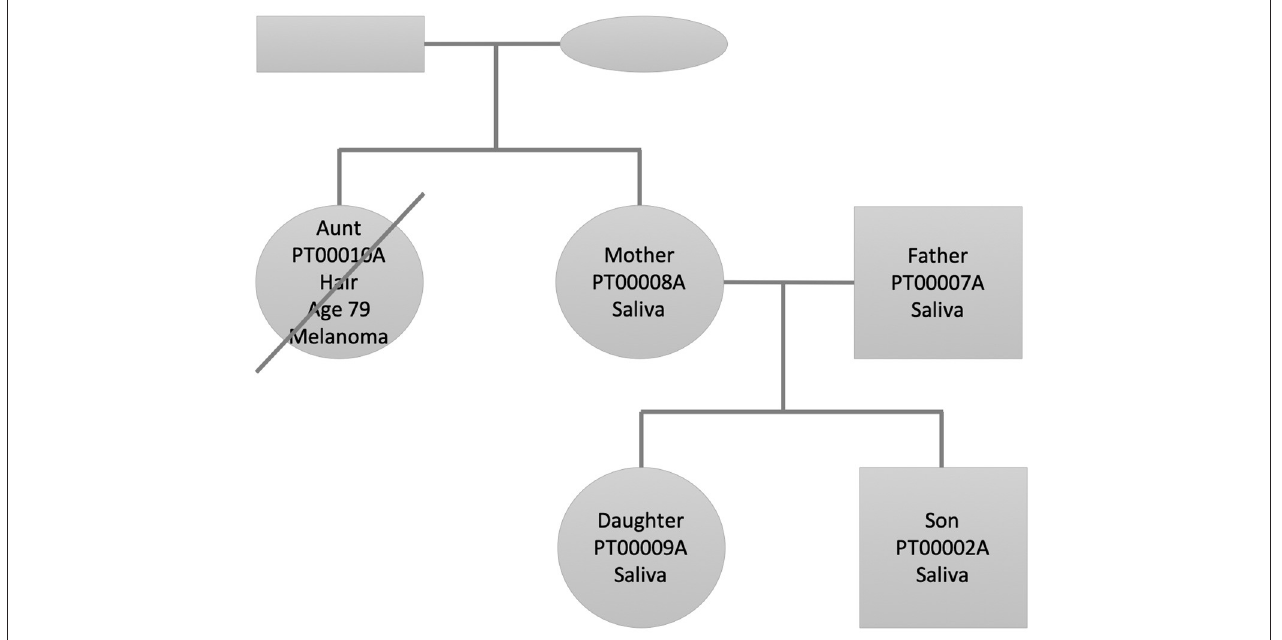
FIGURE 1 | Family pedigree showing the relationship, gender (square: male, circle: female), and sample used for whole genome sequencing (saliva/hair). The crossed circle indicates a deceased individual.